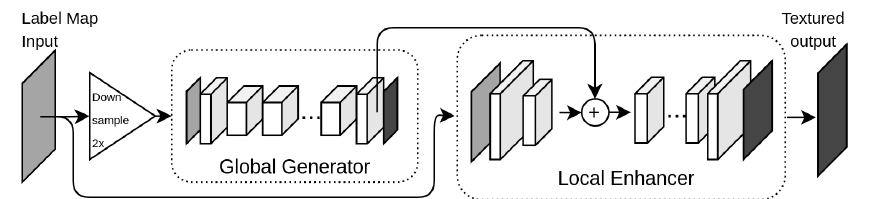
Figure 3. Coarse-to-fine generator of pix 2 pix HD